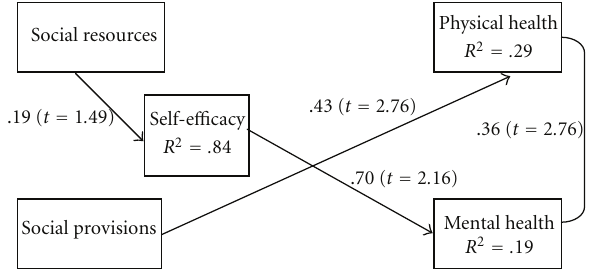
Figure 4: Test results for the support-e ffi cacy model with cente- narians residing in nursing homes; model fit: Satorra-Bentler χ 2 ( N = 105; df = 5) = 6.33; P = . 28; CFI = . 94; RMSEA = . 05; SRMR = . 06 ( using FIML ) . Parameter estimates are from the standardized solution; endogenous variables were controlled for mental status and